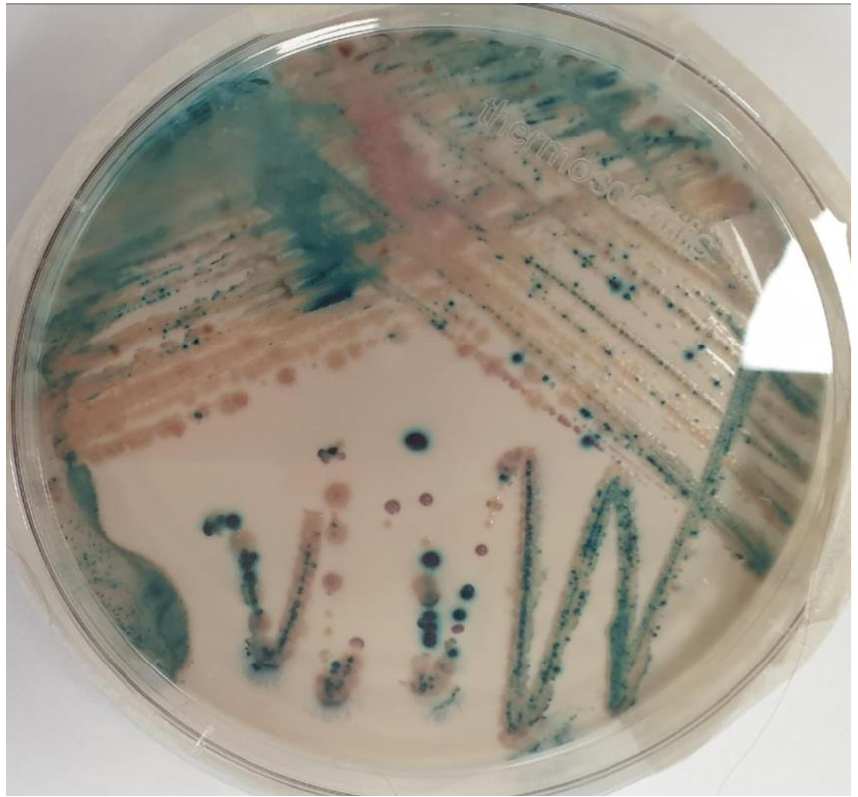
Figure 1. Candida isolates from Brilliance™ Candida Agar Base (Thermo Fisher Scientific TM , Waltham, MA, USA). C. auris (light blue with blue halo colonies), C. krusei (pink and fuzzy colonies) and C. albicans (green – blue colonies).